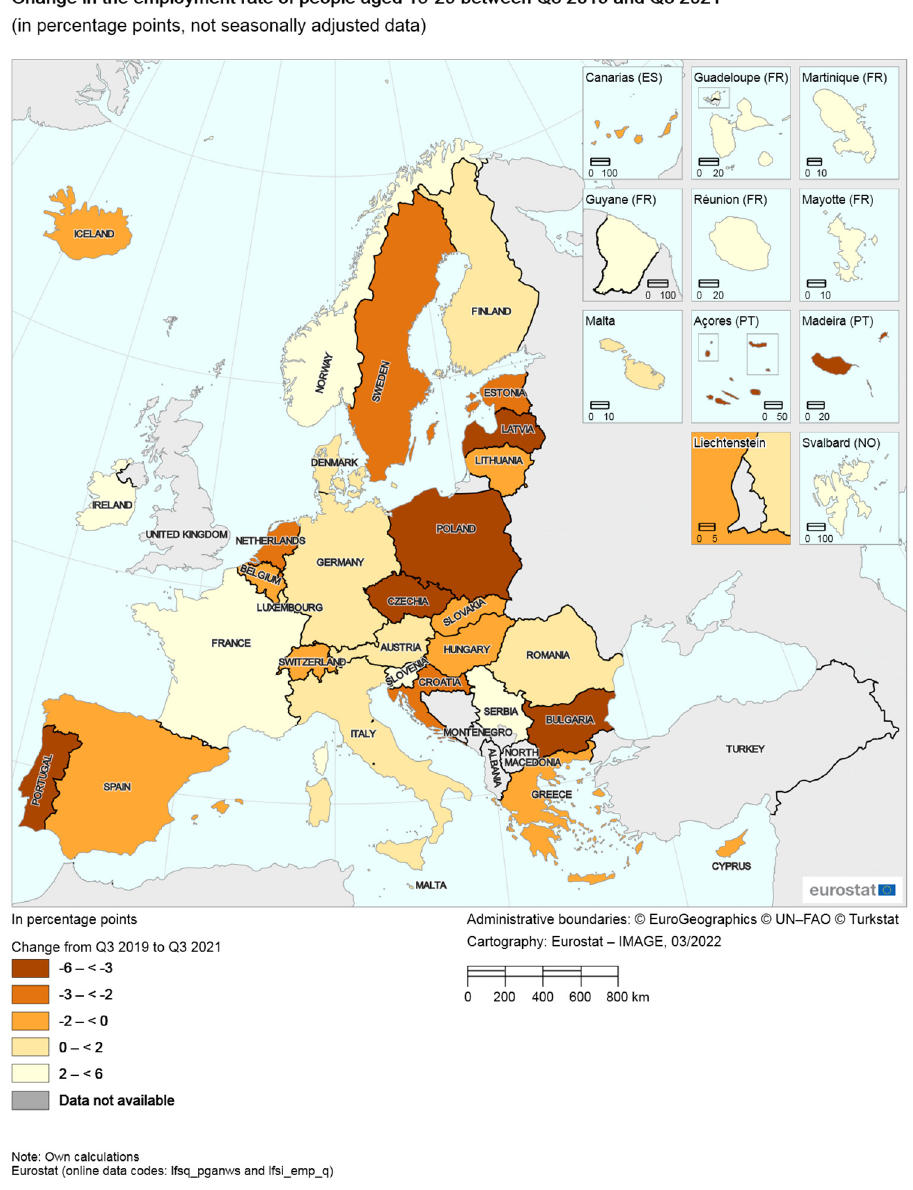
Figure 1. Impact of the COVID-19 crisis for young people (15–29 years). Source: Eurostat (lfsq_pganws) and